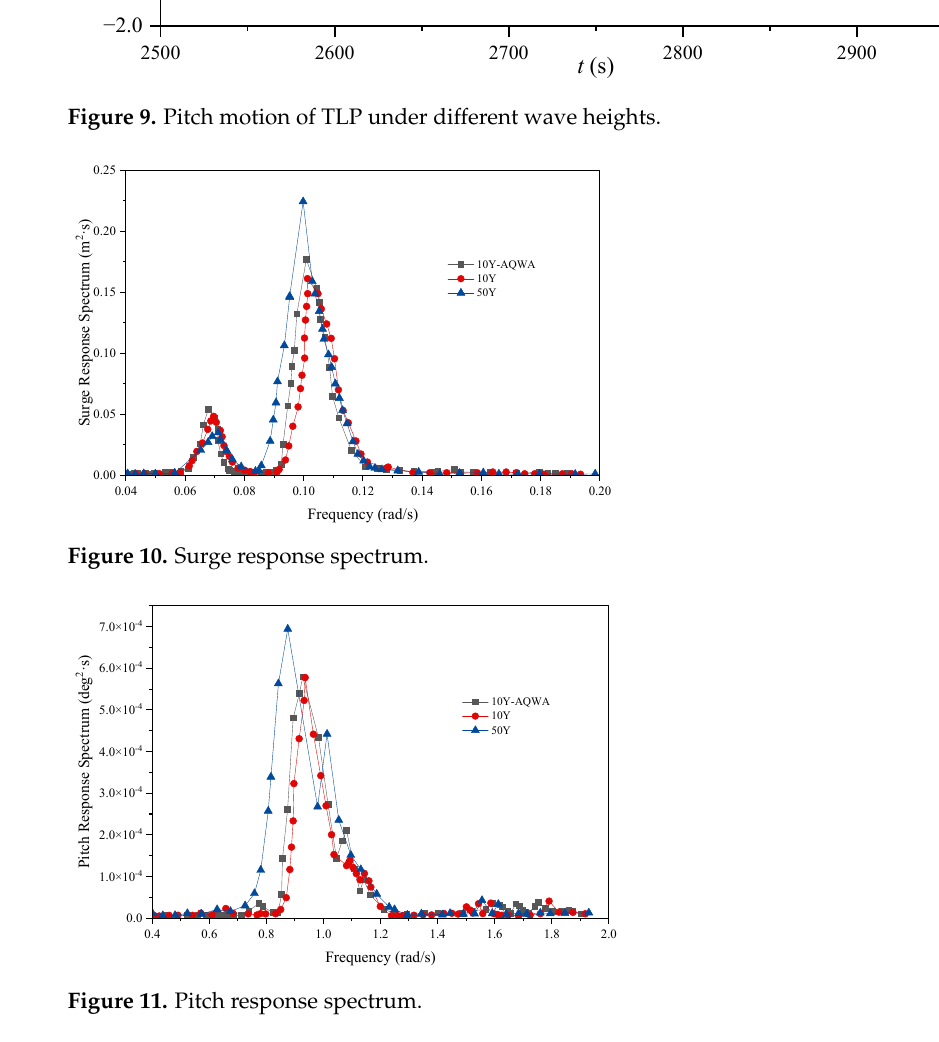
Figure 11. Pitch response spectrum.